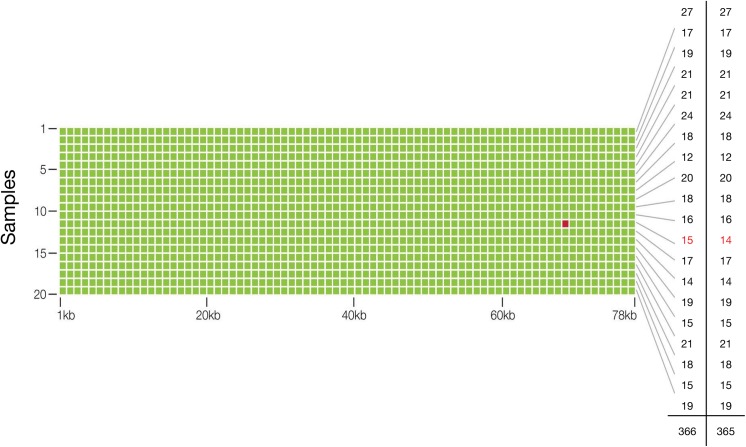
Analytic Specificity and Sensitivity, and Diagnostic Accuracy of the Guardant360 cell-free circulating tumor DNA assay.The matrix illustrates that a targeted region of 78 kbp was sequenced in each of 20 samples to identify single nucleotide variants at approximately 2.0–5.0% MAF (heterozygous) in circulating cfDNA. Green dots represent concordant single nucleotide variant (SNV) calls for digital sequencing of 10 ng cfDNA to calls made by whole exome sequencing of 2 μg of genomic (leukocyte) DNA from the same sample. The red dot represents the single false positive result in a cumulative 1.56 million bases sequenced. The far right-hand column illustrates the number of SNVs per sample identified with exome sequencing, and the penultimate column with digital sequencing, for a total of 365 and 366 SNVs, respectively.